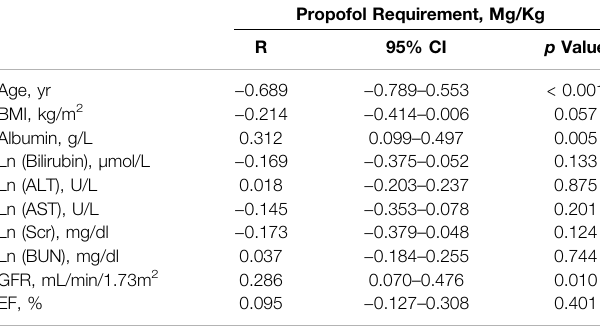
TABLE 3 | Correlation coef fi cients between age and propofol requirement. Propofol Requirement,